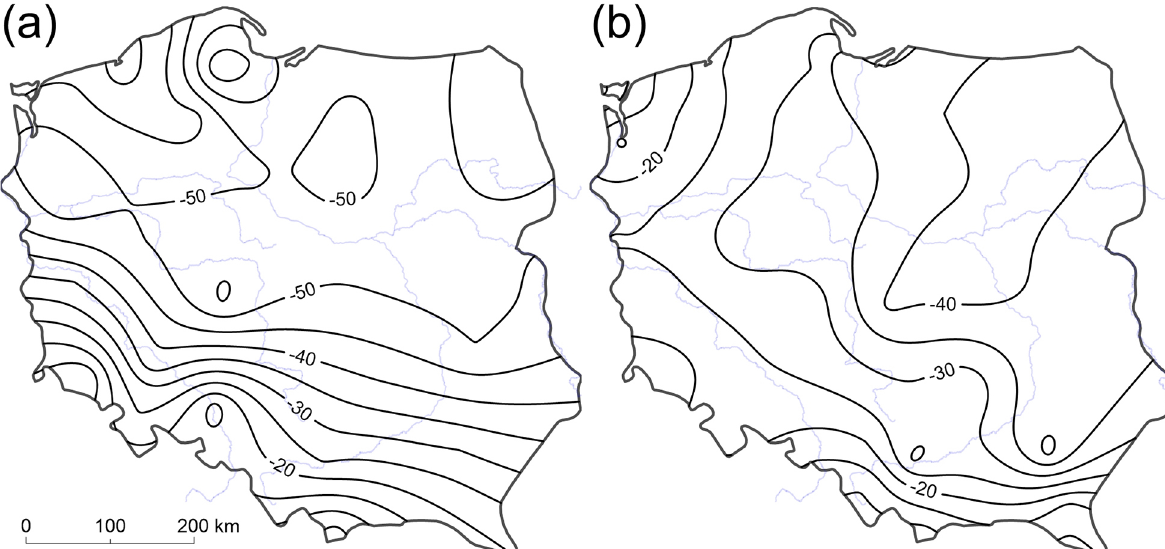
Fig. 6. UTCI values (°C) in Poland on selected days: 31 December 1978 (A) and 30 January 2014 (B). UTCI, Universal Thermal Climate